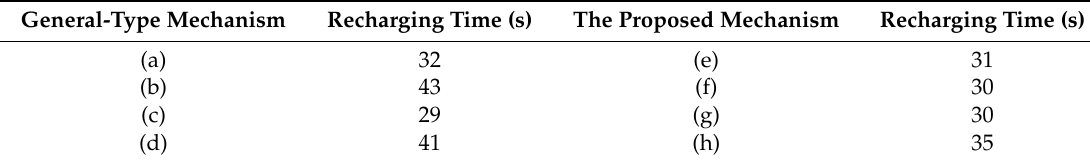
Table 14. Time spent in the second part of